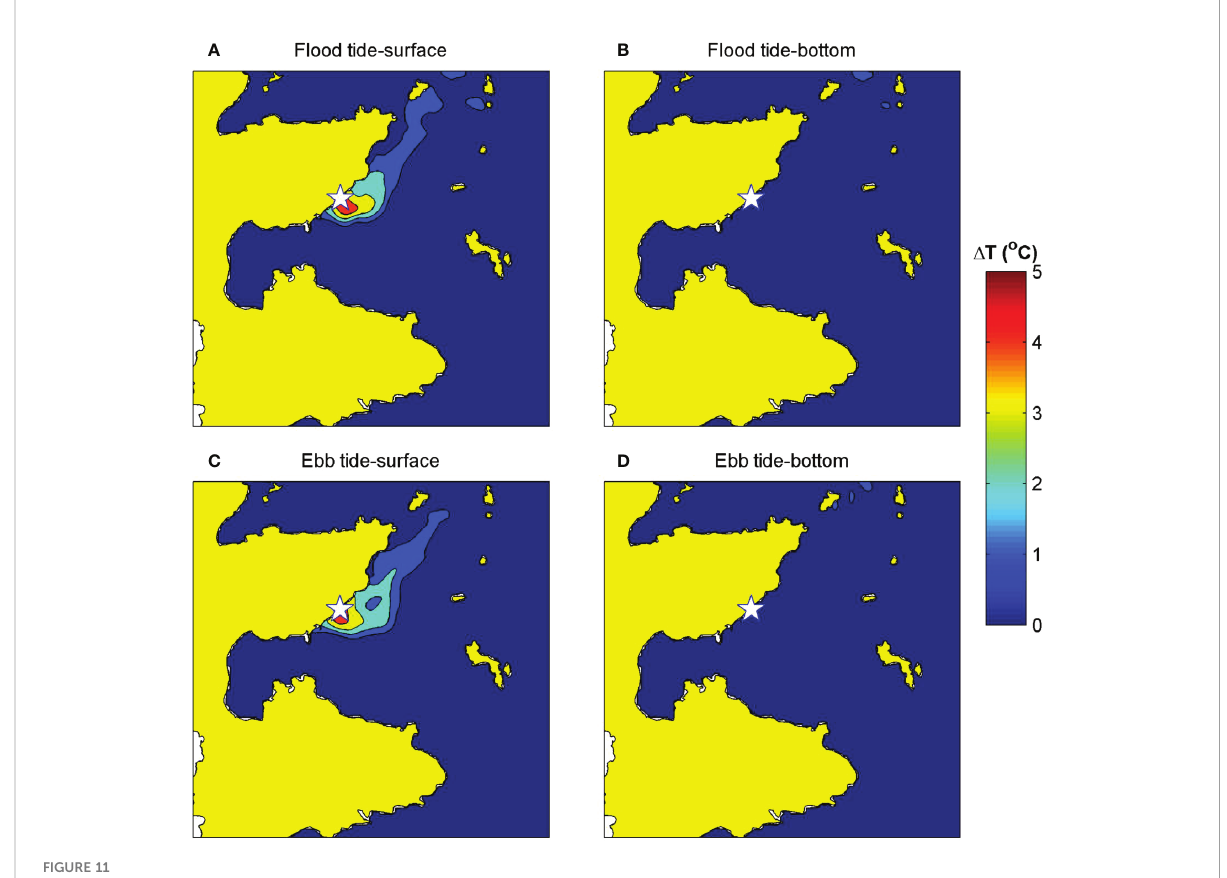
FIGURE 11 Same as Figure 11, but during neap tide.